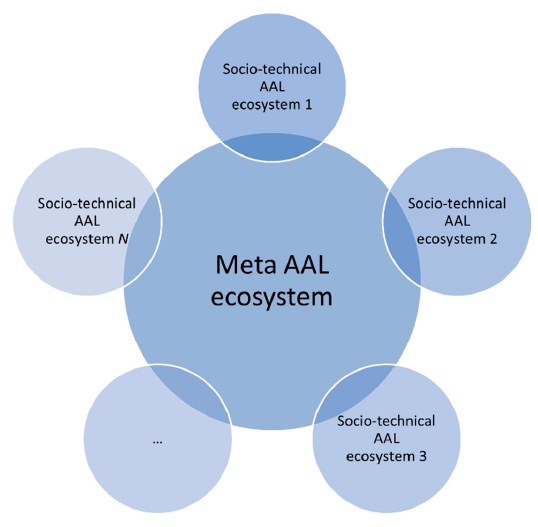
Figure 5. Meta AAL